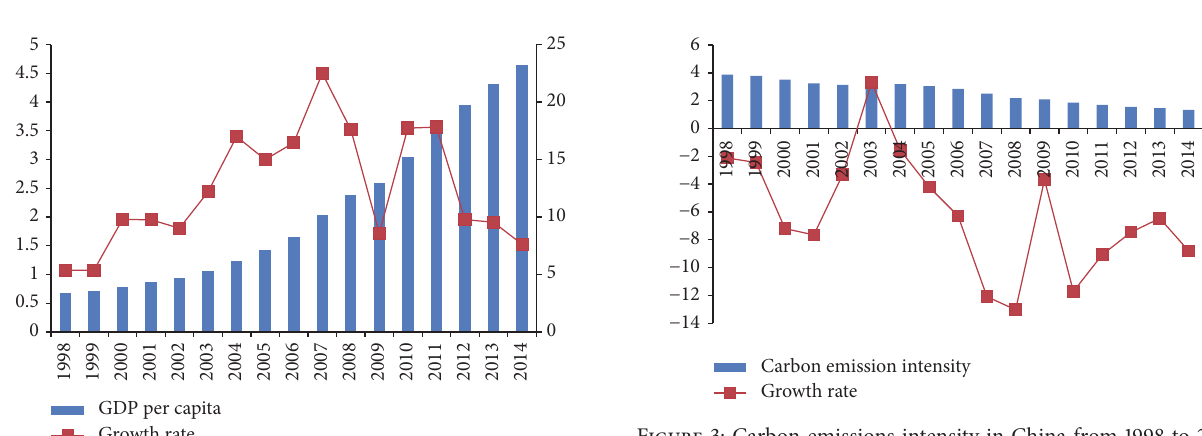
Figure 3: Carbon emissions intensity in China from 1998 to 2014 (ton/ten thousand yuan) and the growth rate (%).